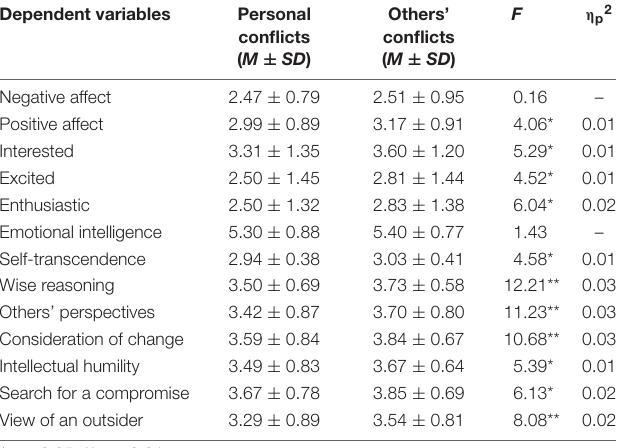
TABLE 2 | The main impact of conflict type on wise reasoning and related variables.